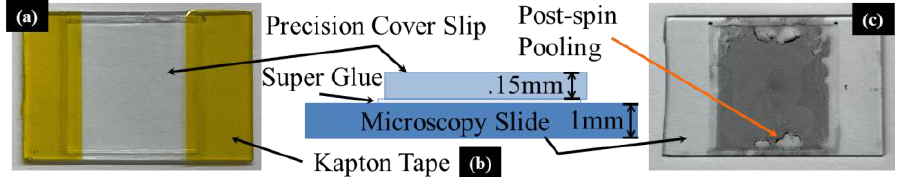
Figure 1. ( a ) Clean sample prepared for spin coating; ( b ) cross-sectional view of sample layer con- figuration; ( c ) sample post deposition of nanocomposite mixture exhibiting undesirable